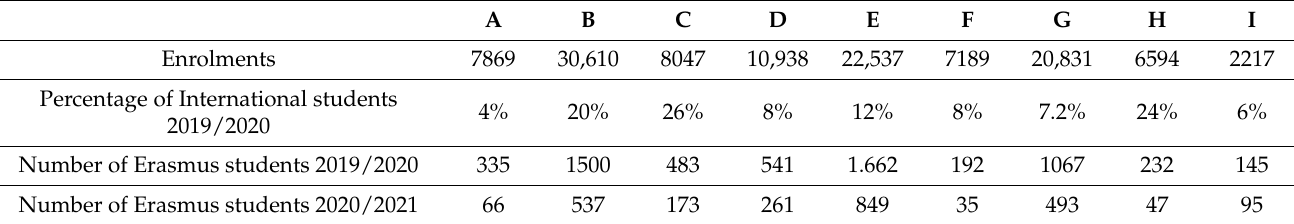
Table 1. Characterization of case study universities